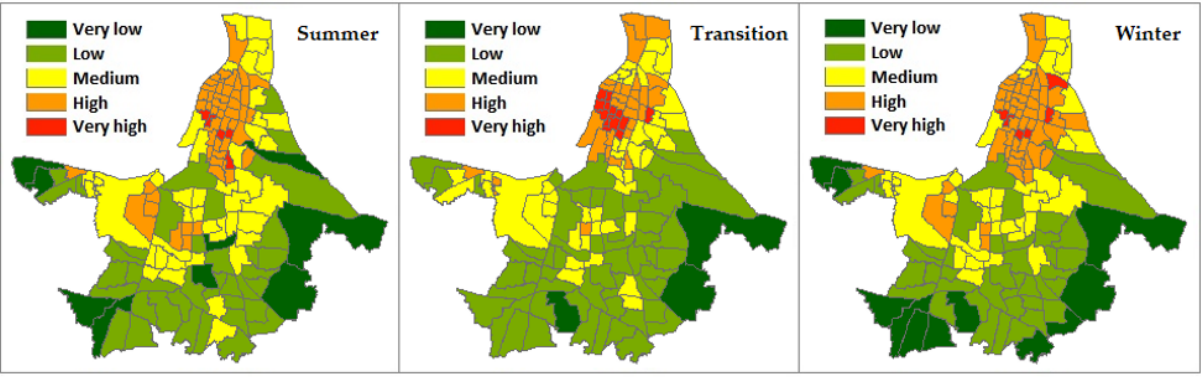
Figure 5. Spatial variability of LST in the different seasons.